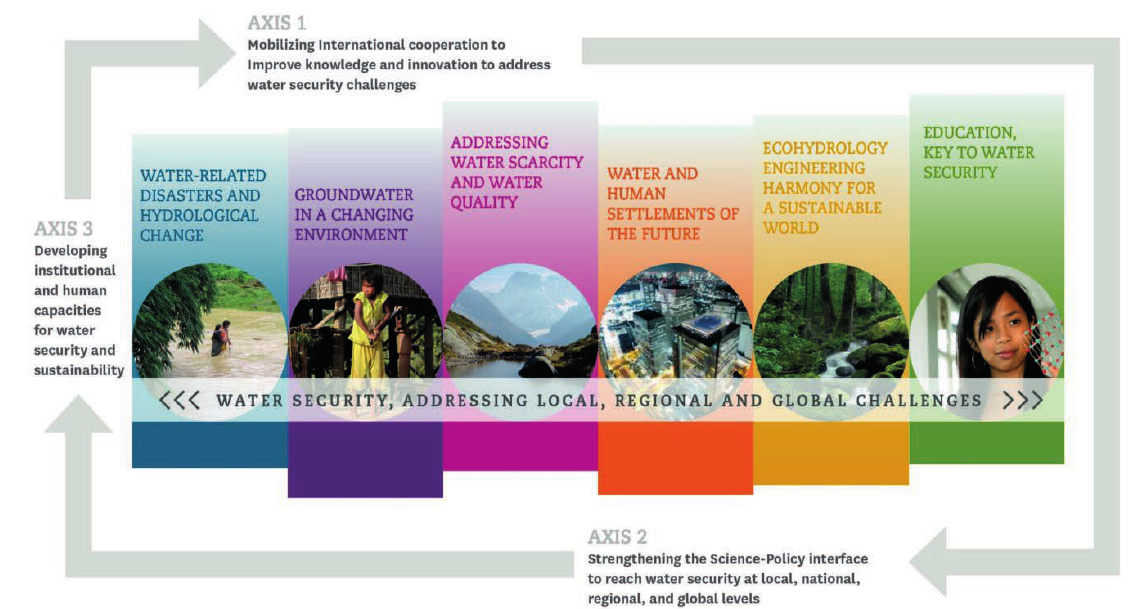
Fig. 1 Overview of themes and action axes of IHP-VIII, Water Security: Responses to Local, Regional and Global Challenges (2014–2021).